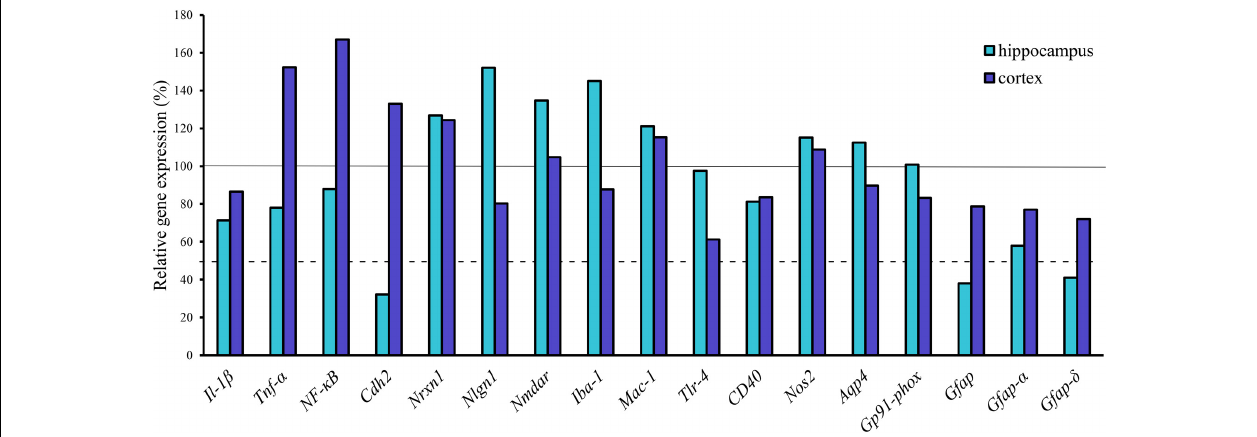
FIGURE 6 | Gene expression analysis of neuroinflammatory markers, transporters and Gfap isoforms in the hippocampus and cortex of APOB-100 transgenic mice. Continuous line indicates the expression level of the corresponding gene in wild-type mice (100%). Dashed line indicates the level of significant changes: a 0.5 fold (50%) reduction in gene